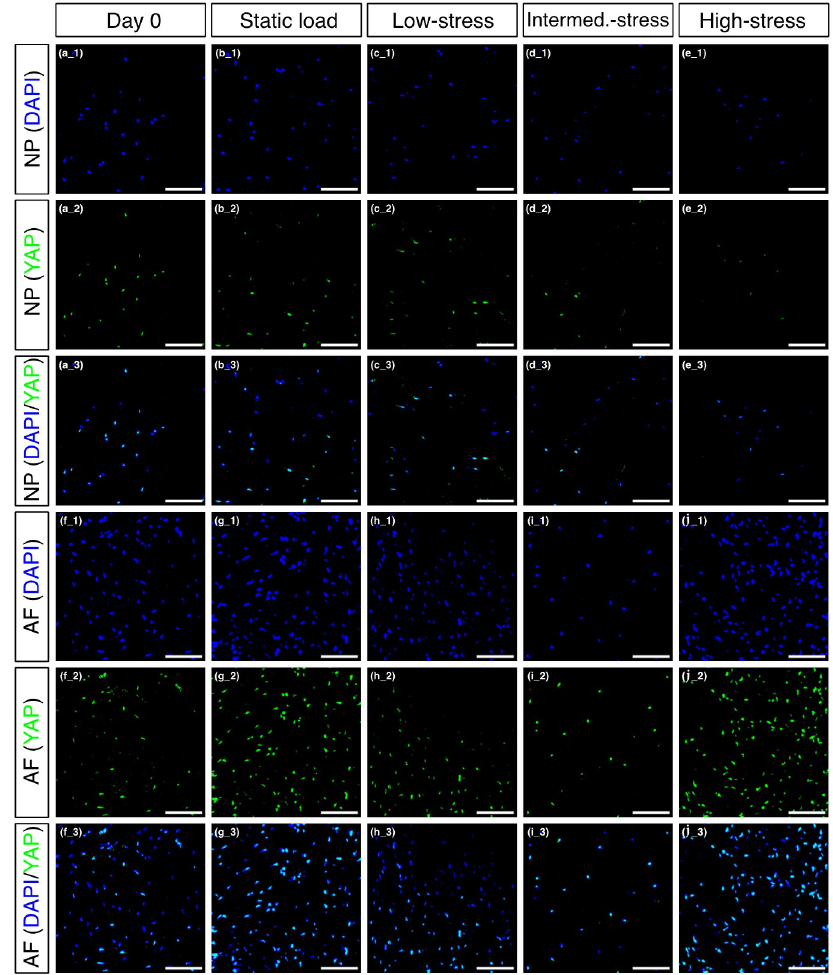
Figure 4. Immunofluorescent pictures of the nucleus pulposus (NP) and in the annulus fibrosus (AF). The sections were stained with DAPI (blue) and anti-YAP (green) and are shown individually as well as merged. ( a ) NP cells at day 0, ( b ) NP cells after static load, ( c ) NP cells after low-stress load, ( d ) NP cells after intermediate-stress load, ( e ) NP cells after high-stress load, ( f ) AF cells at day 0, ( g ) AF cells after static load, ( h ) AF cells after low-stress load, ( i ) AF cells after intermediate-stress load, ( j ) AF cells after high-stress load. Scale bar = 100 µ